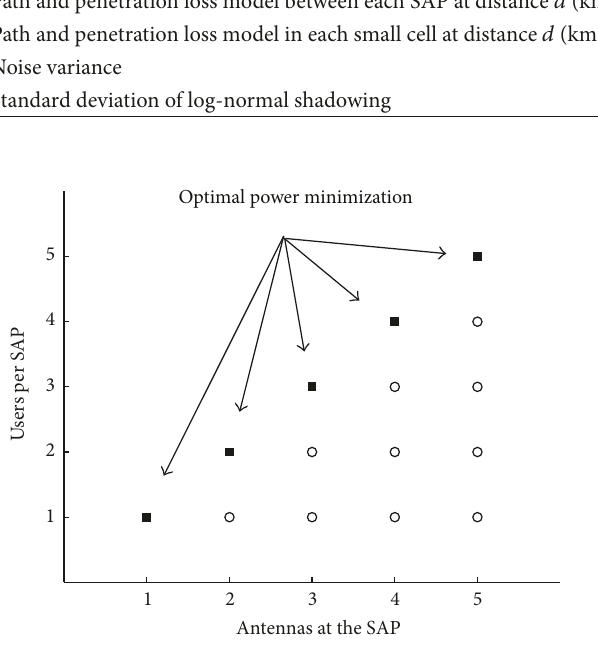
Figure 3: Distribution of solutions.